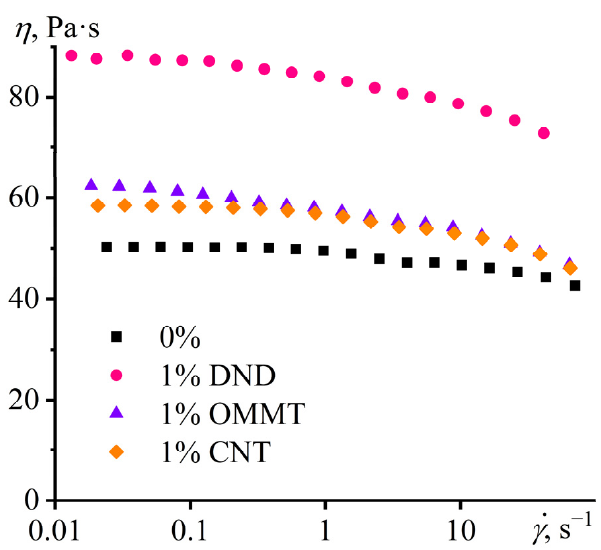
Figure 9. Dependences of viscosity on the shear rate for epoxy resin and 1% dispersions of nano- particles in it at 20 °C.